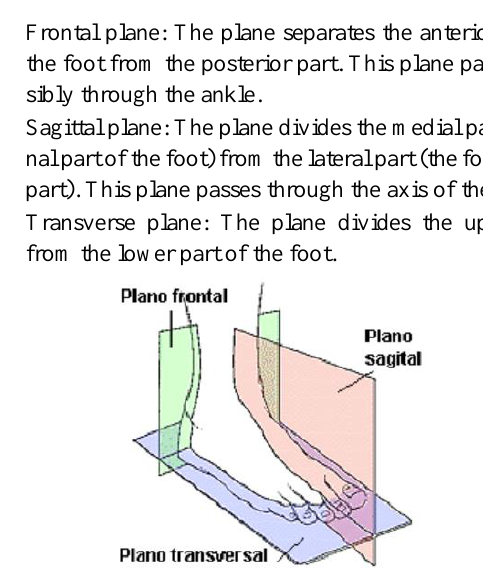
Figure 1. Foot reference planes (Caetano 2020)